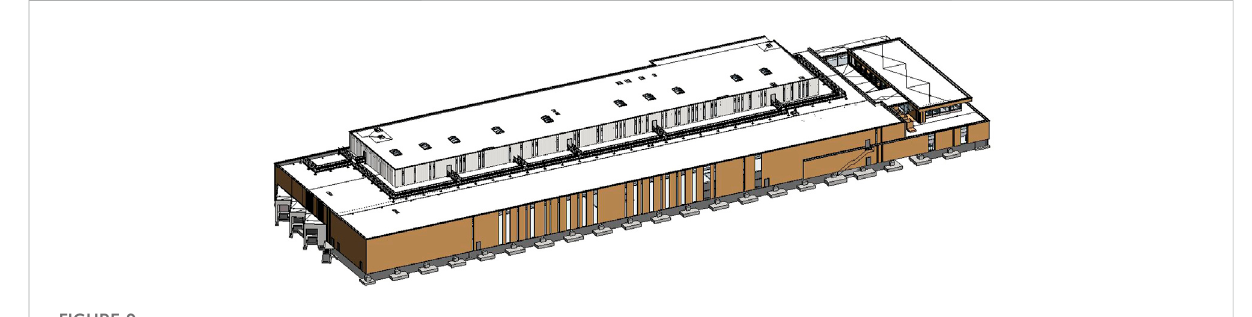
FIGURE 9 3D view of the case study BIM model in Revit.